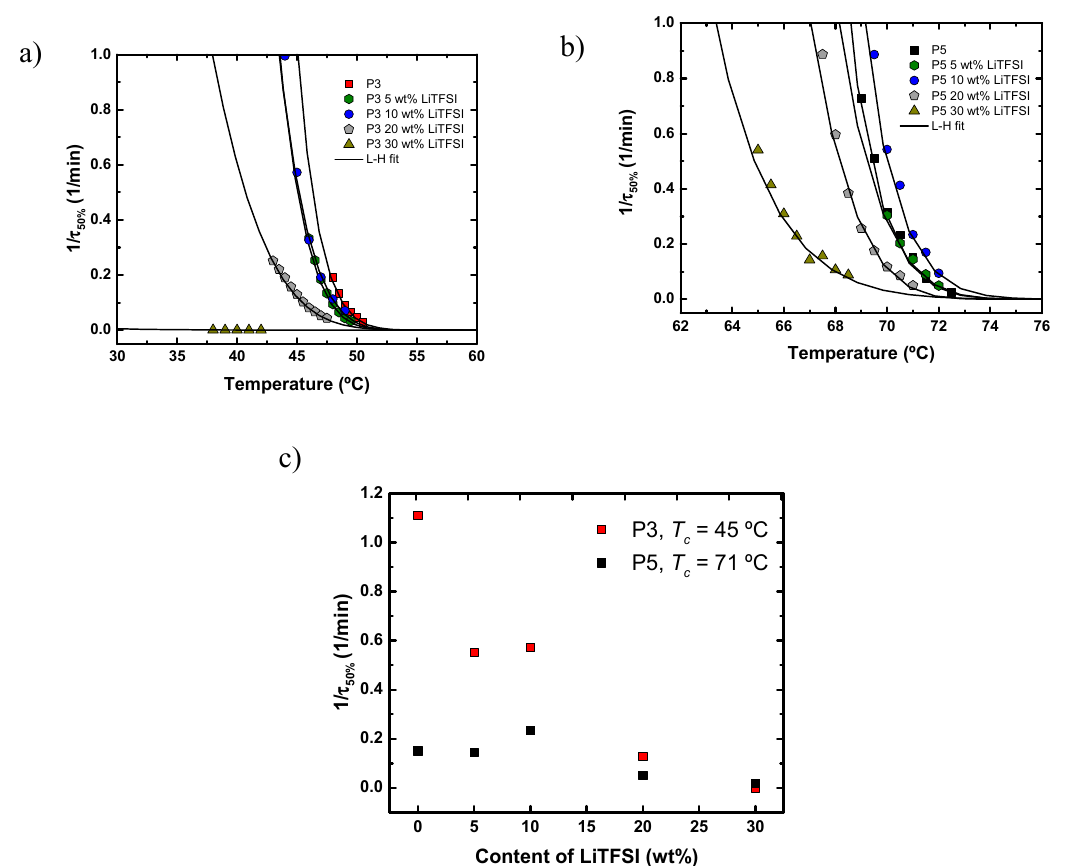
Figure 7. ( a ) Overall crystallization rate (expressed as the inverse of the half-crystallization time) versus isothermal crystallization temperature for P3 and SPEs-P3. ( b ) Overall crystallization rate (expressed as the inverse of the half-crystallization time) versus isothermal crystallization temperature for P5 and SPEs-P5. Symbols: experimental data. Solid lines show fittings to the Lauritzen and Hoffman theory. ( c ) Overall crystallization rate (expressed as the inverse of the half-crystallization time) versus the content of LiTFSI at constant crystallization temperatures (notice that T c values are different for each series), whose values are indicated in the legend.